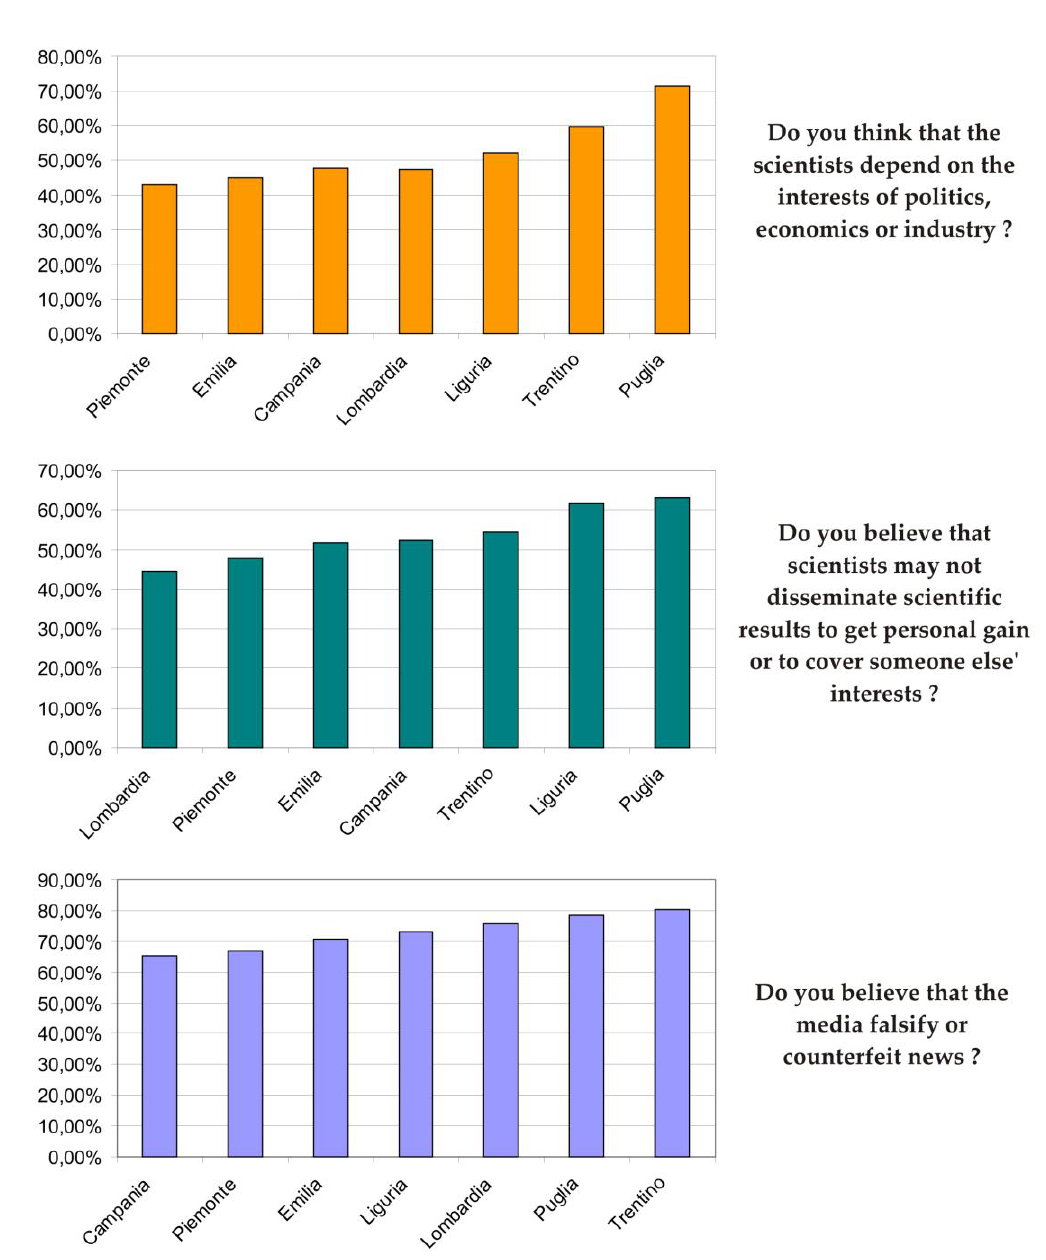
Figure 3. Comparison of the answers (top to bottom) relative to the integrity (dependence of scientists from outer urges) of scientists, their tendency to hide information to the society and the manipulation of informa- tion from the media. The Emilia is among the regions in which students have most trust in